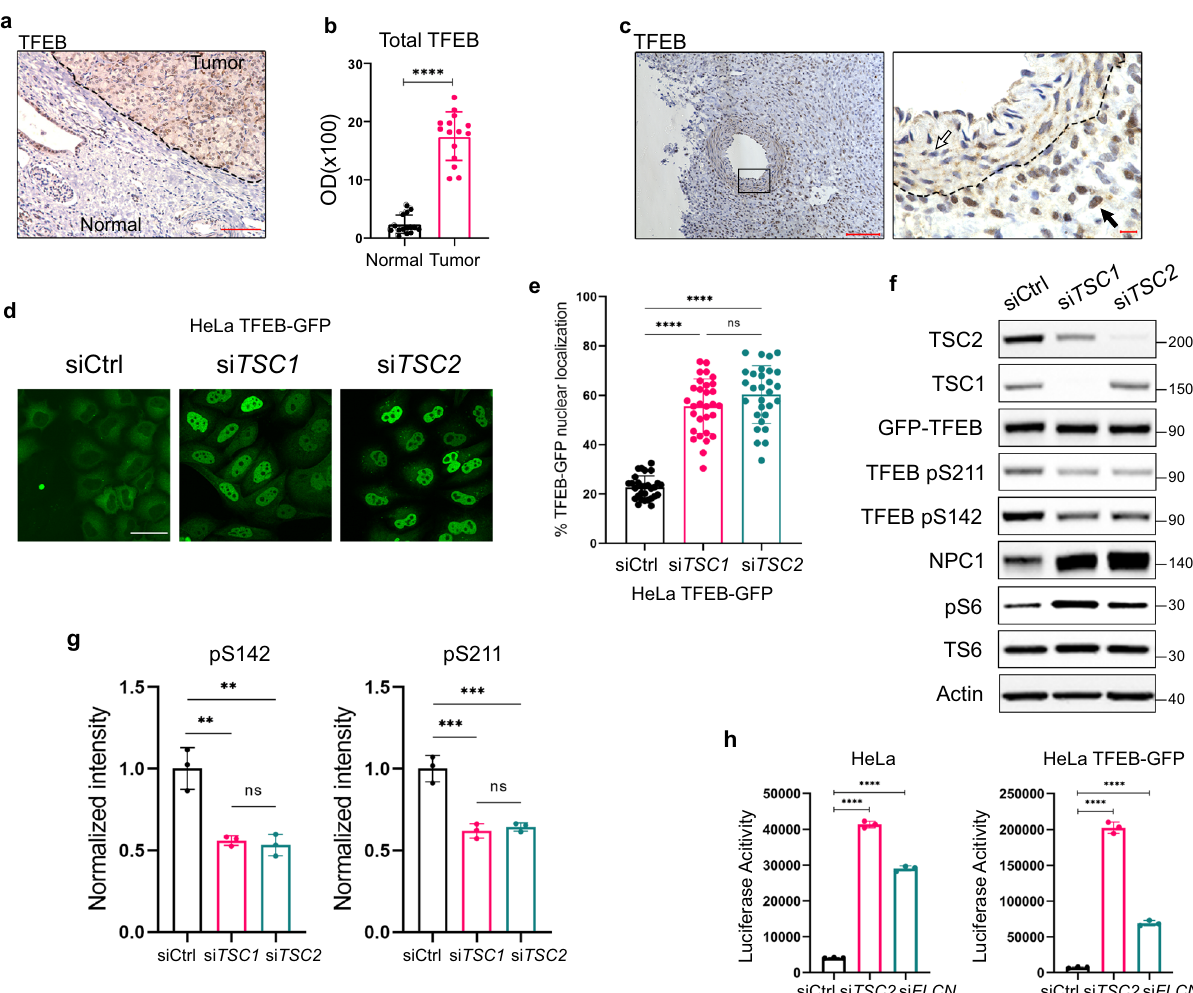
Fig. 2 TSC2 loss induces nuclear localization and increased transcriptional activity of TFEB. a TFEB is increased and primarily nuclear in TSC-associated renal cell carcinoma. The dashed line shows the boundary between tumor and normal adjacent kidney. Scale bar = 100 µ m. b TFEB optical density quanti fi ed from a, (15 measurements on 5 random areas of tumor and normal adjacent kidney quanti fi ed per section in 3 patient samples). c TFEB is primarily nuclear in human angiomyolipoma compared to blood vessel. The dashed line shows the boundary between tumor cells on the right and a blood vessel on the left. The black arrow indicates nuclear TFEB in a tumor cell. The white arrow indicates cytoplasmic TFEB in the cells of the blood vessel wall ( n = 3 patient samples). Left image scale bar = 100 µ m, right image scale bar = 10 µ m. d , e HeLa-TFEB-GFP cells were transfected with TSC1 or TSC2 siRNA for 72 h and visualized with confocal live imaging. Scale bar = 50 µ m ( d ). The nuclear/cytoplasmic ratio of GFP was quanti fi ed using ImageJ as described in methods, ( n = 3 random fi elds per condition, 29 cells for Ctrl siRNA, 30 cells for TSC1 siRNA and 29 cells for TSC2 siRNA were analyzed) ( e ). f Representative immunoblotting of HeLa-TFEB-GFP cells transfected with Ctrl, TSC1 or TSC2 siRNA for 72 h ( n = 3 biological replicates per condition). Blot was analyzed by staining with the indicated antibodies, phospho-S6 (S235/S236) is the indicator of increased mTORC1 activity, NPC1 is the indicator of TFEB transcriptional activity. g Densitometry for phospho TFEB S142 and phospho TFEB S211 was performed using ImageJ and normalized to total TFEB- GFP ( n = 3 biological replicates per condition). h Luciferase activity of HeLa and HeLa-TFEB-GFP stably expressing the GPNMB luciferase reporter and transfected with TSC2 or FLCN (as positive control) siRNAs for 72 h ( n = 3 biological replicates per condition). Graphs are presented as mean ± SD. Statistical analyses were performed using two-tailed Students t -test or one-way ANOVA if more than two groups, * *p < 0.01, *** p < 0.001, **** p < 0.0001. Source data are provided as a Source data fi